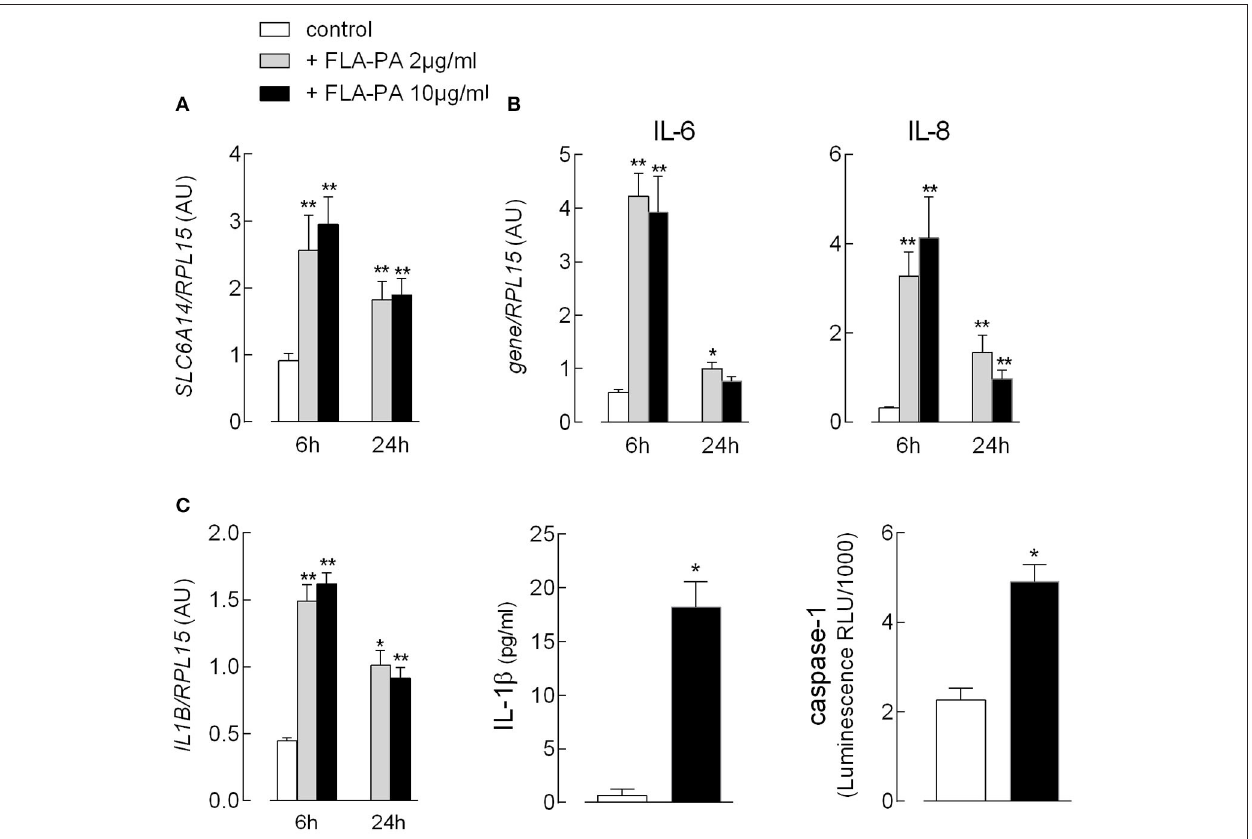
FIGURE 5 | EpiAirway TM tissues were incubated in the absence (control) or in the presence of the indicated concentrations of FLA-PA. After 6h, the expression of the indicated genes (A,B) was measured by means of RT-qPCR analysis and shown after normalization for that of the housekeeping gene (RPL15) . Data of three experiments, each performed in duplicate, are presented as mean ± SEM. (C) The activation of inflammasome was monitored after 16h by addressing the expression of interleukin-1 β (IL-1 β ) mRNA (left) and the cytokine secretion (middle) with RT-qPCR and ELISA assay, respectively; the activity of caspase-1 (right) was measured in parallel, as described in section “Materials and methods”. Bars represent the mean ± SEM of three experiments. * p < 0.05, ** p < 0.01 vs.